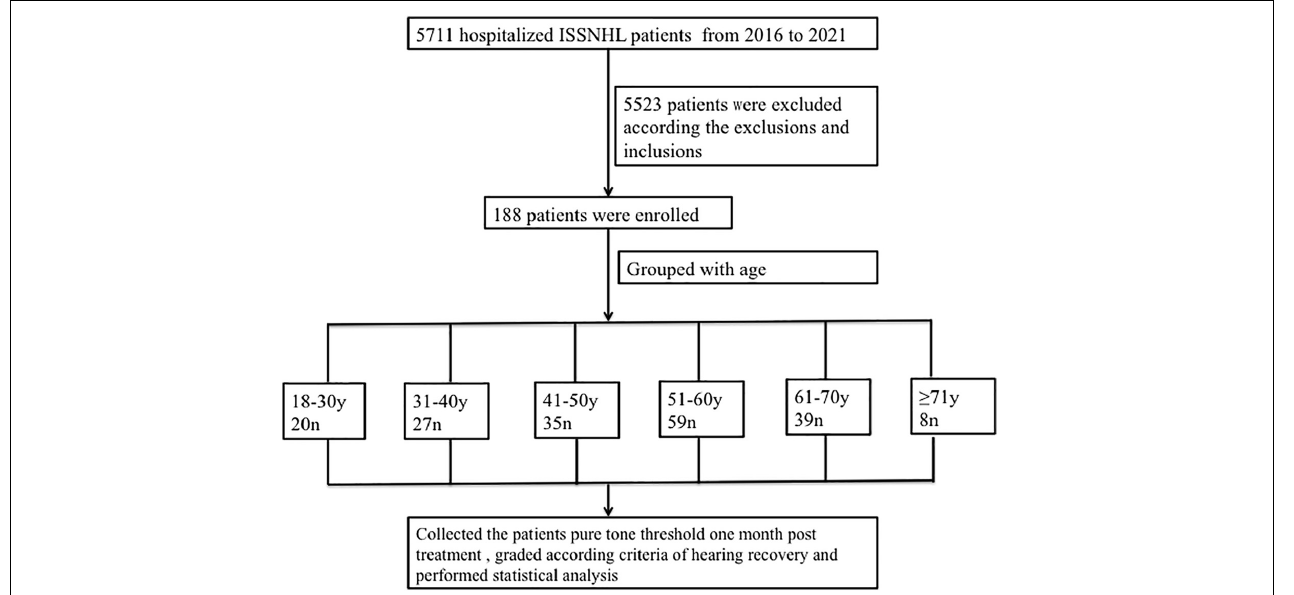
FIGURE 1 | Research flow diagram. ISSNHL, idiopathic sudden sensorineural hearing loss; n, number; y, year.